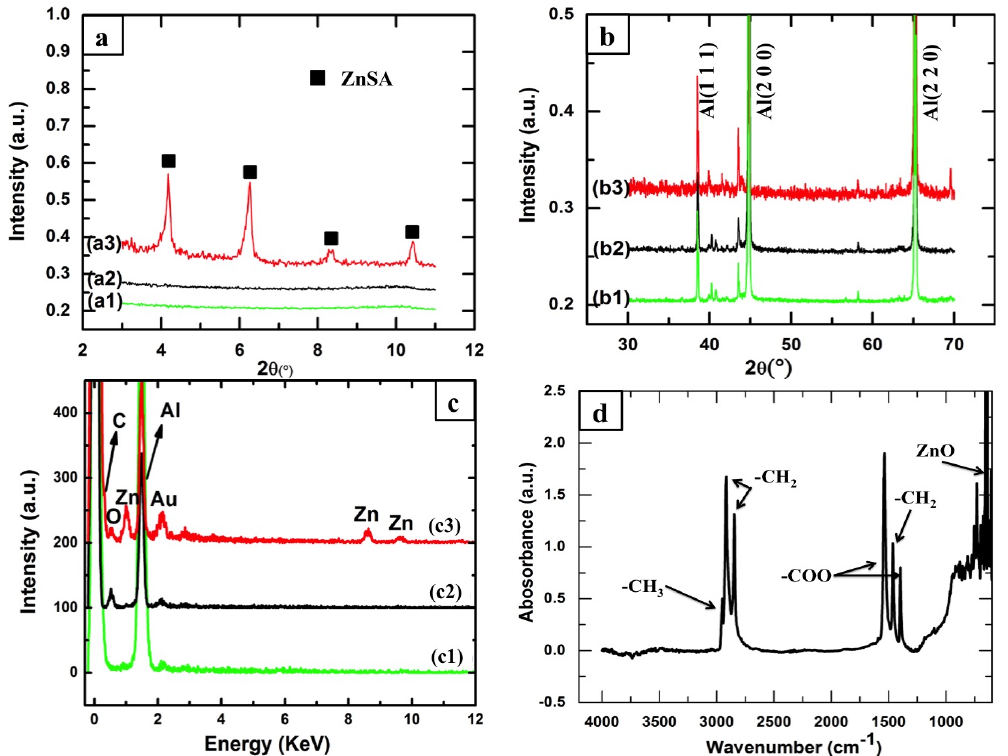
Figure 2. ( a ) Low angle XRD patterns of ( a1 ) as-received aluminum alloy, ( a2 ) AAO, ( a3 ) electrodeposited anodized substrate; ( b ) high angle XRD patterns of ( b1 ) as-received aluminum alloy, ( b2 ) AAO and ( b3 ) electrodeposited anodized substrate; ( c ) EDX spectra of ( c1 ) the as-received aluminum alloy, ( c2 ) anodized and ( c3 ) electrodeposited anodized substrate (ZnSA = zinc stearate); ( d ) FTIR spectrum of the electrodeposited anodized substrate.